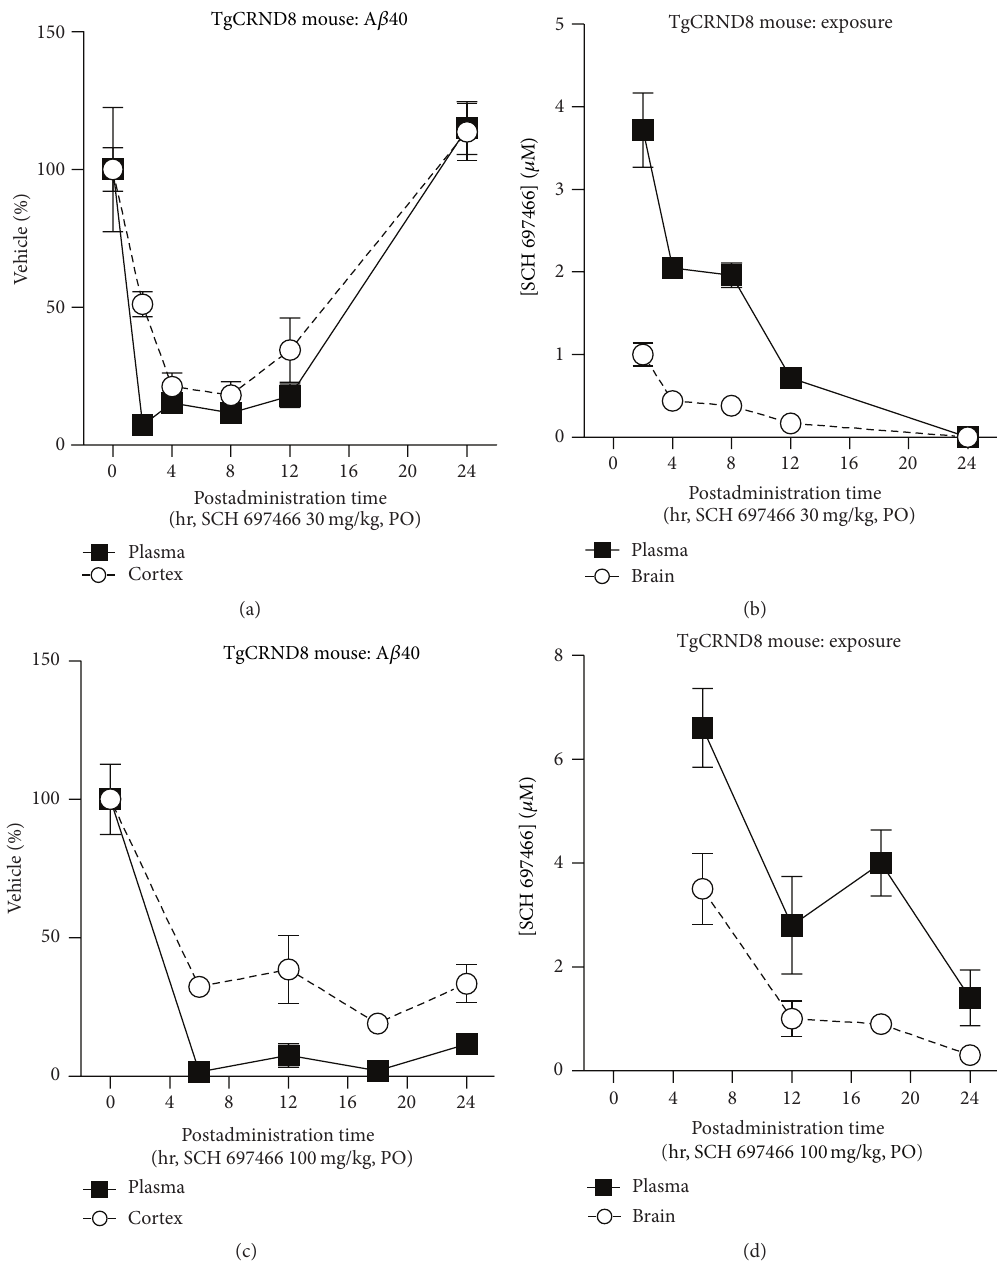
Figure 3: A 𝛽 40 levels over time expressed as a percent of vehicle in plasma and cortex following a single dose of (a) 30mg/kg or (c) 100mg/kg of SCH 697466 in TgCRND8 mice. Plasma and brain concentration ( 𝜇 M) of SCH 697466 following a single dose of (b) 30mg/kg or (d) 100mg/kg of SCH 697466 in TgCRND8